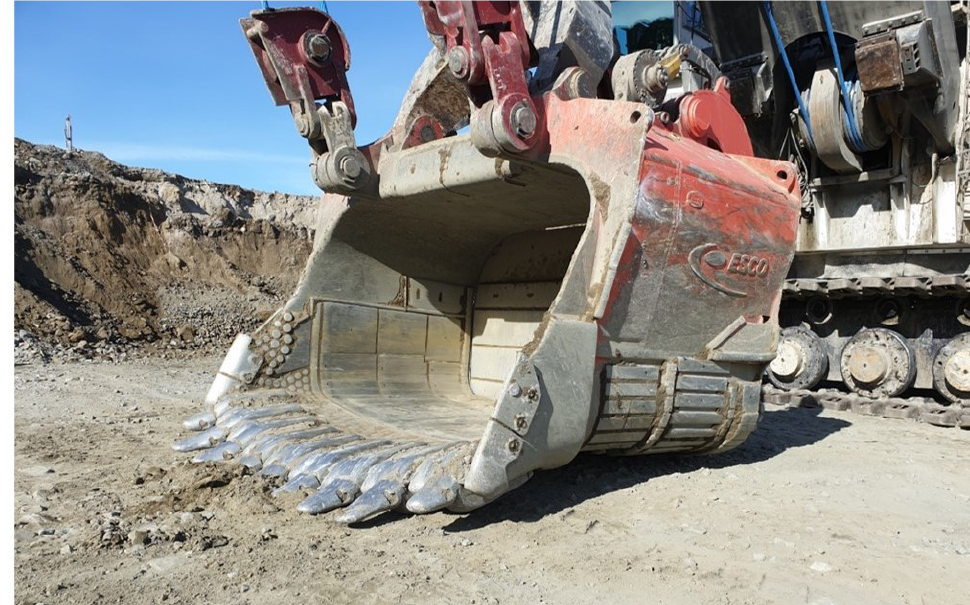
Figure 4. A photograph showing the 43 m 3 large Esco bucket mounted on the Bucyrus electric rope shovel (ERS) in